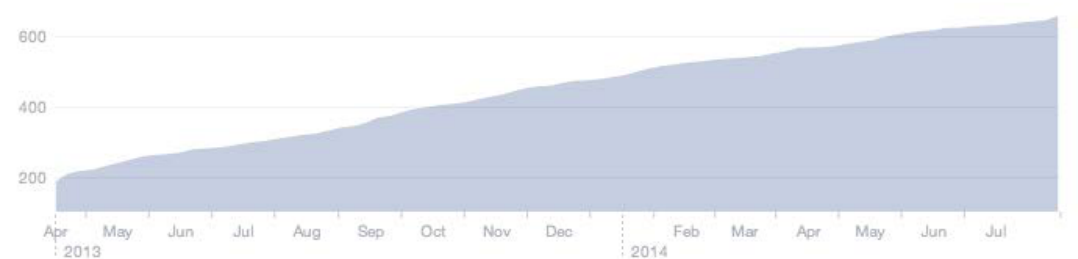
Figure 9. Total number of page “likes” per day. Rate of “likes” closely follows the rate of student completion.